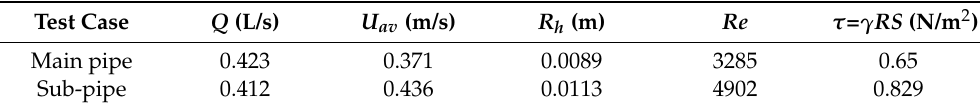
Table 4. Pilot test results of flow performance for the main pipe and sub-pipe, discharge Q (L/s), averaged velocity U av (m/s), hydraulic radius R h (m), Reynolds number Re , and average shear stress τ (N/m 2 ).